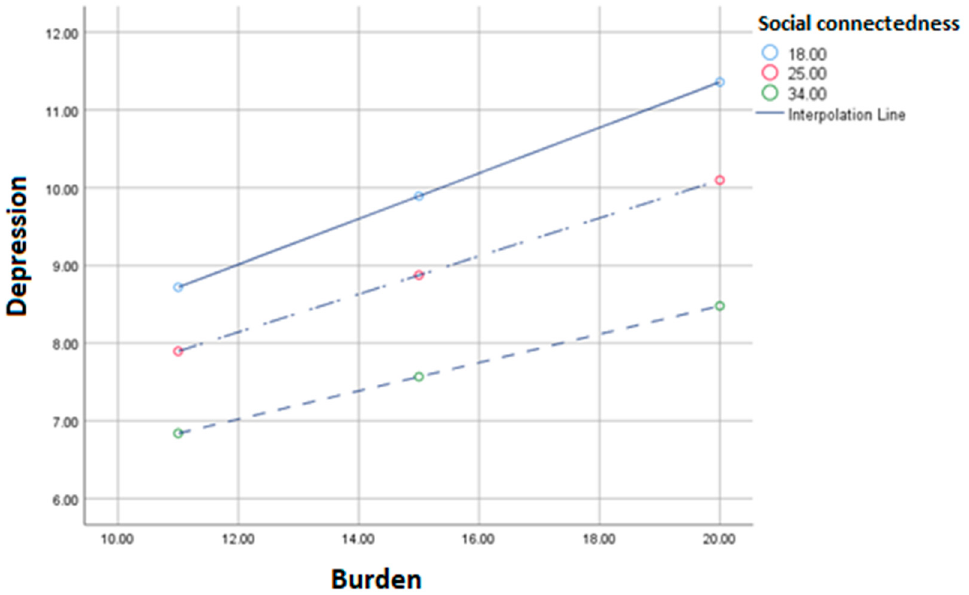
Figure 1. Moderation of the relationship between caregiver burden and depression symptoms when perceived social connectedness is low (18), medium (25), or high